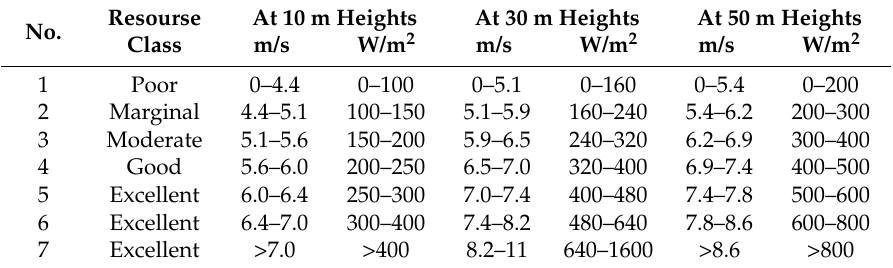
Table 2. International standards of wind power generation classification at various